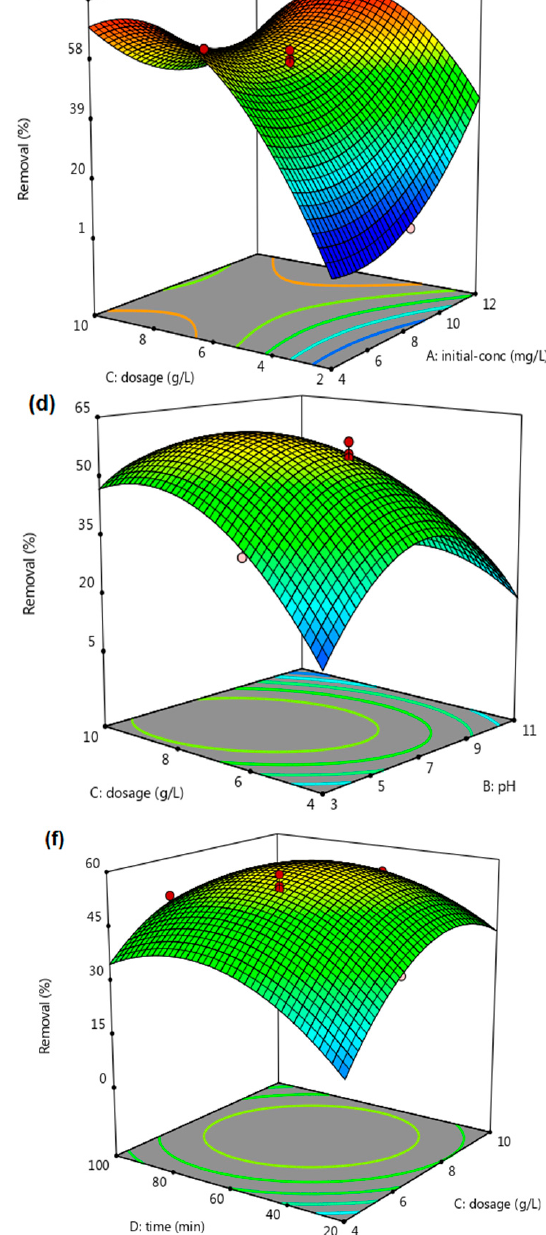
Figure 7. 3D plots of fluoride adsorption by the PG adsorbent showing the interaction effect of ( a ) F − concentration and pH, ( b ) F − concentration and dosage, ( c ) F − concentration and time, ( d ) pH and dosage, ( e ) pH and time, and ( f ) time and dosage. 3.4.1. Effect of Solution pH Solution pH is a pronounced factor that can greatly affect the amount of ionic ad- sorbate removed because it has the ability to alter the nature of ionic adsorbate molecule